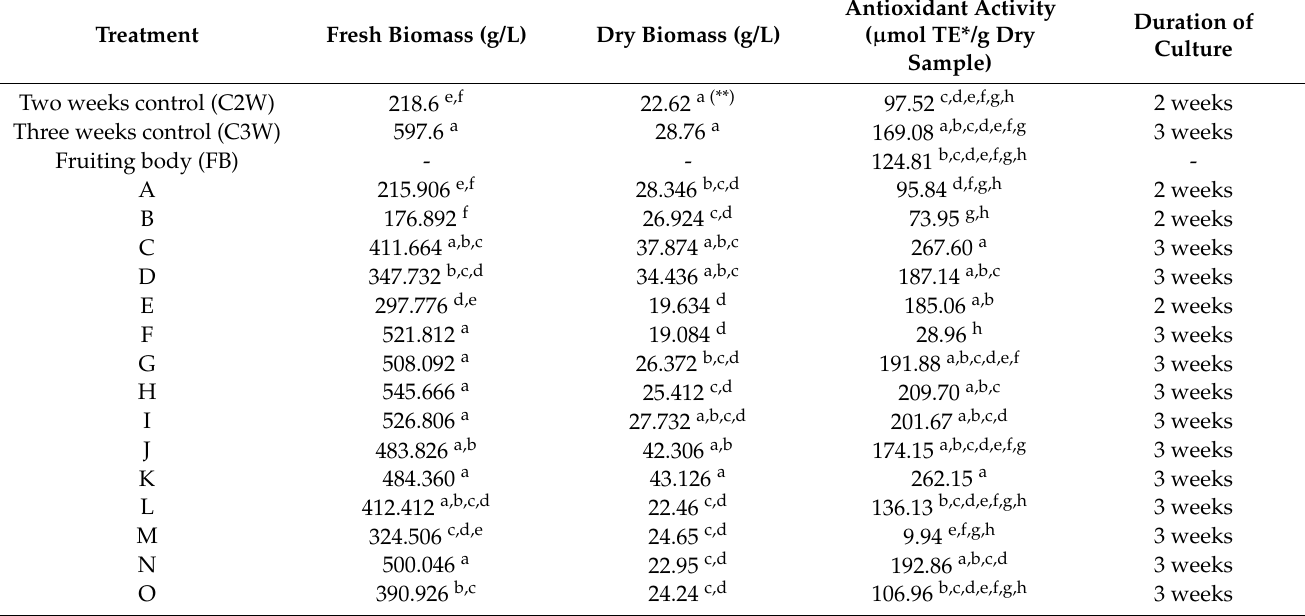
Table 2. Fresh biomass, dry biomass, and antioxidant activity of untreated in vitro Ganoderma sp. Cultures (C2W, C3W, FB), treated with high and low pH for 2 weeks and three weeks (A–F), growth regulators (G–I), high and low nitrogen availability (J,K) ethanol (L), salts in the medium (M–O) and the Ganoderma sp. fruiting